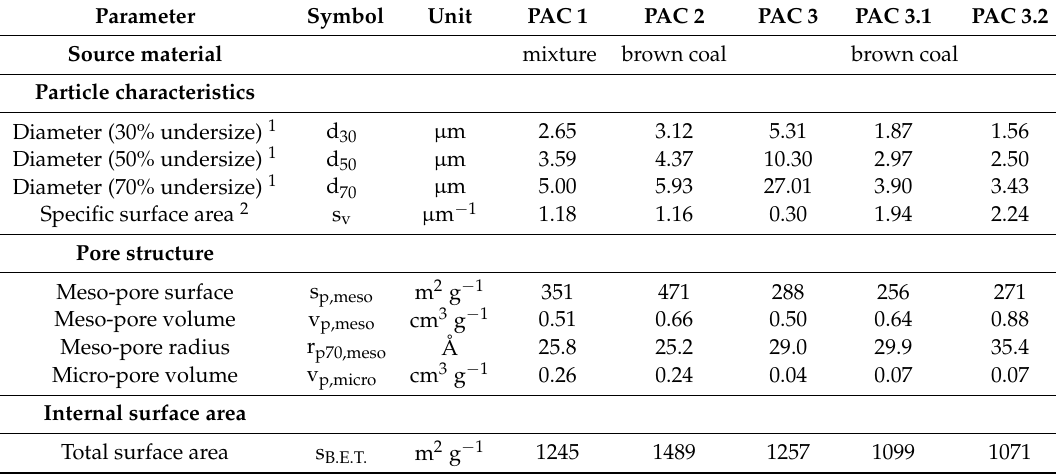
Table 2. Determined structural properties of all PAC products tested in this study. (PAC 3.1 & 3.2 are milled carbons from